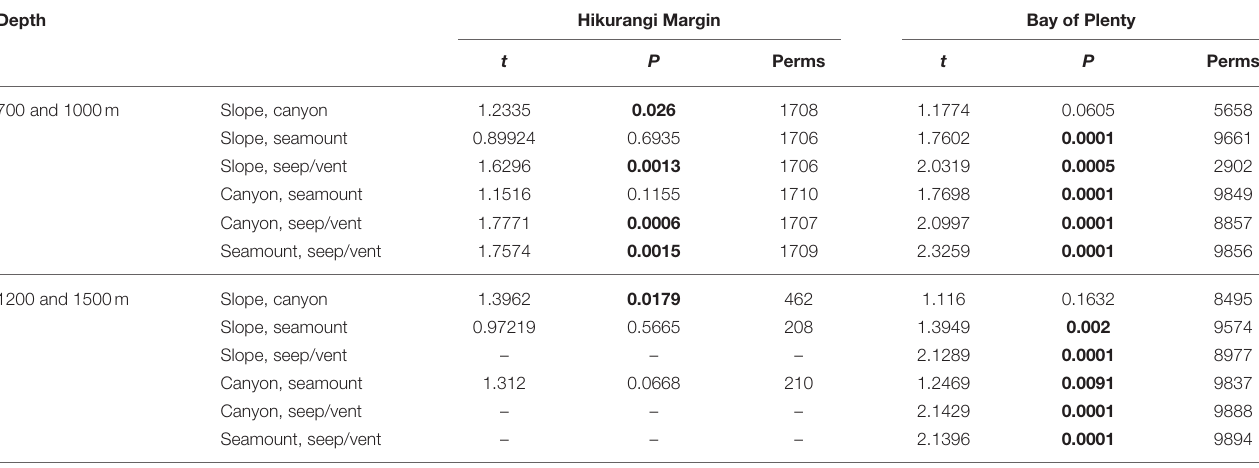
TABLE 4 | Results of pairwise PERMANOVA analyses testing for the effects Habitat (slope, canyon, seamount, and seep or vent habitats) on community structure in Hikurangi Margin and Bay of Plenty regions. Depth